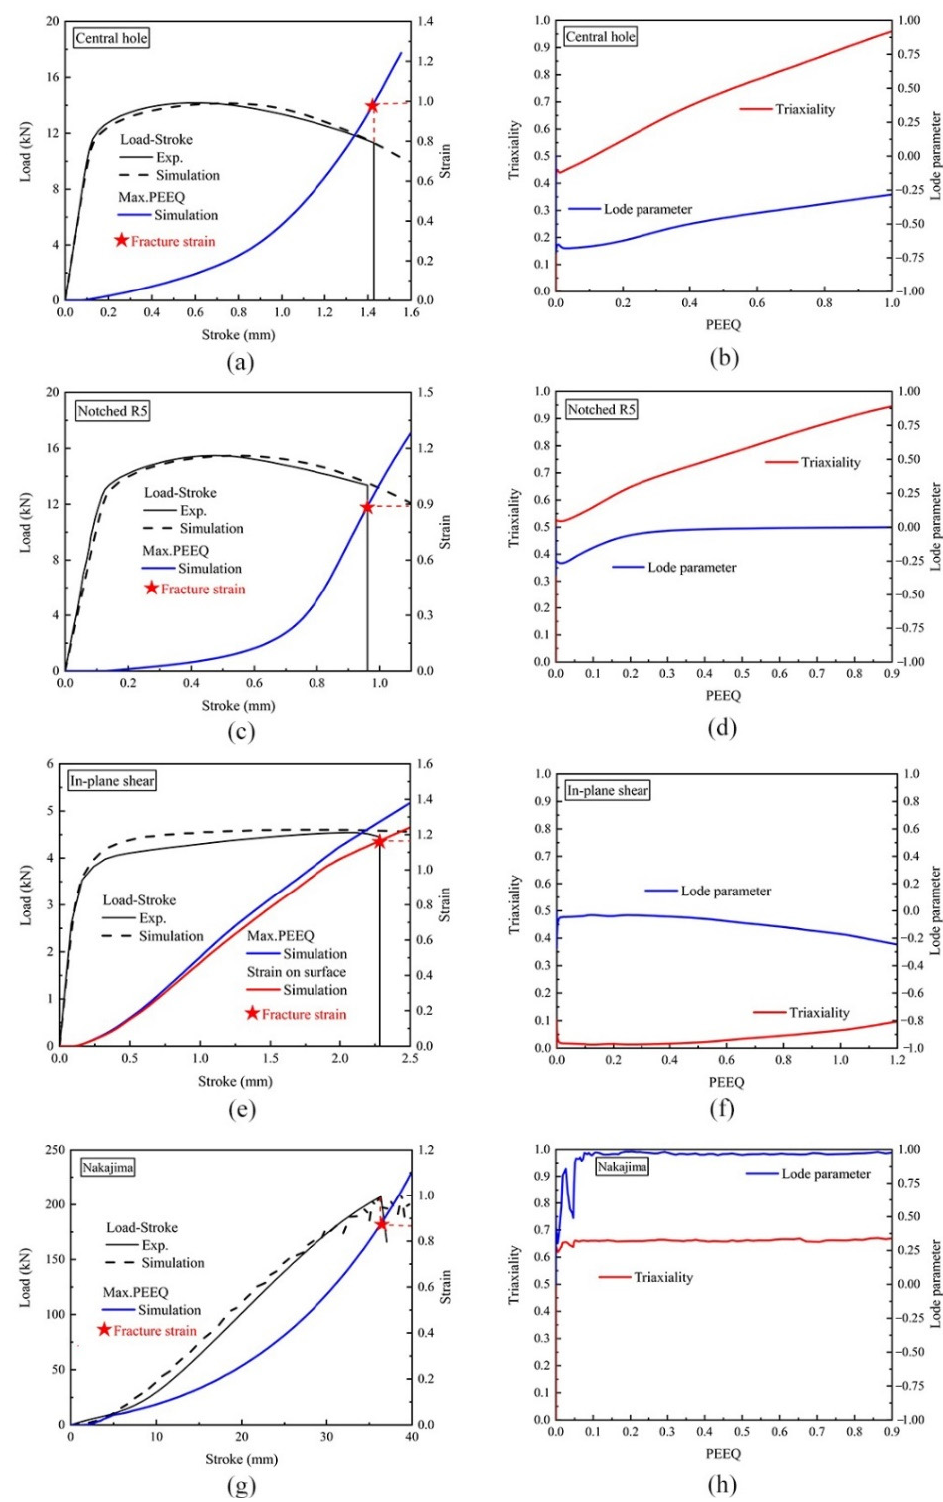
Figure 14. Numerical and experimental tensile results for different bainite specimens: ( a ) central hole, ( c ) notched, ( e ) in-plane shear, and ( g ) Nakajima specimen simulated load–stroke curves and PEEQ distribution, compared with experimental results; ( b ) central hole, ( d ) notched, ( f ) in-plane shear, and ( h ) Nakajima specimen calculated evolutions of the Lode parameter and the triaxiality towards PEEQ.